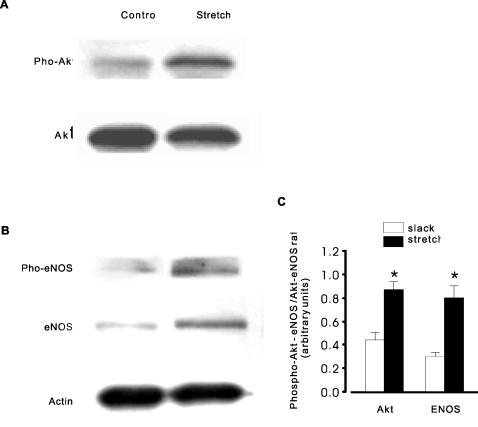
Stretch-induced Akt/eNOS phosphorylation and eNOS up-regulation in smooth muscle.Mouse bladder tissue strips were stretched to and maintained at 30% of slack length at least for 10 min, and then frozen. A & B, representative western blots showing Akt and eNOS phosphorylation and expression. Stretching of smooth muscle strips induced a significant increase in the phosphorylation of both Akt (204±28.6%) and eNOS (258±36.8%), respectively. It was noted that the eNOS protein level was also up-regulated by stretch. C, densitometry for ratio of Akt and eNOS phosphorylation to Akt and eNOS expression. Results are expressed as mean±SEM (n>8 mice for each group). *P<0.05 compared with control (slack).